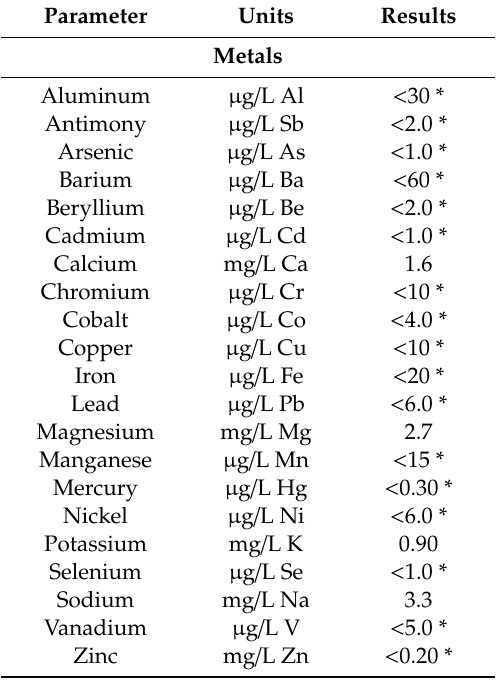
Table 3. Metal analysis of Monfortinho thermal water (n =